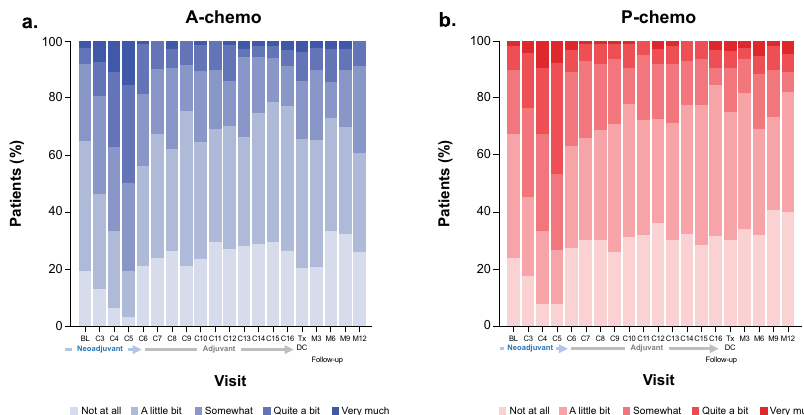
Fig. 4 Proportion of patients selecting each response option by visit in the FACT-G GP5 item in the atezolizumab-chemotherapy and placebo-chemotherapy arms. Proportion of patients selecting each response option by a visit in the FACT-G GP5 item ( “ I am bothered by side effects of treatment ” ) in a the atezolizumab-chemotherapy arm and b the placebo-chemotherapy arm. BL baseline, C cycle, M month, Tx DC treatment